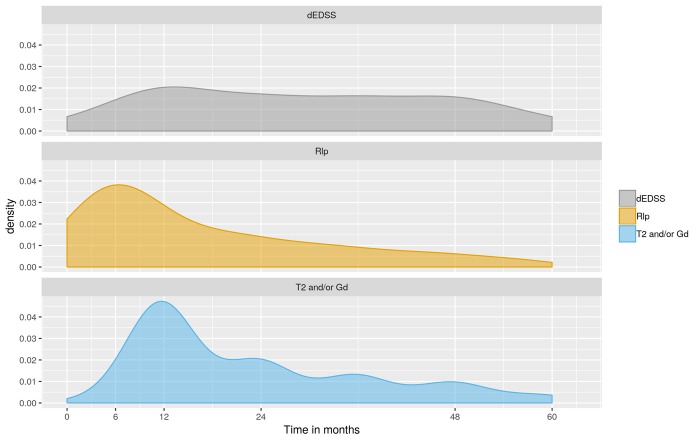
Density of causes for NEDA-3 failure.Abbreviations: NEDA-3, no evidence of disease activity.